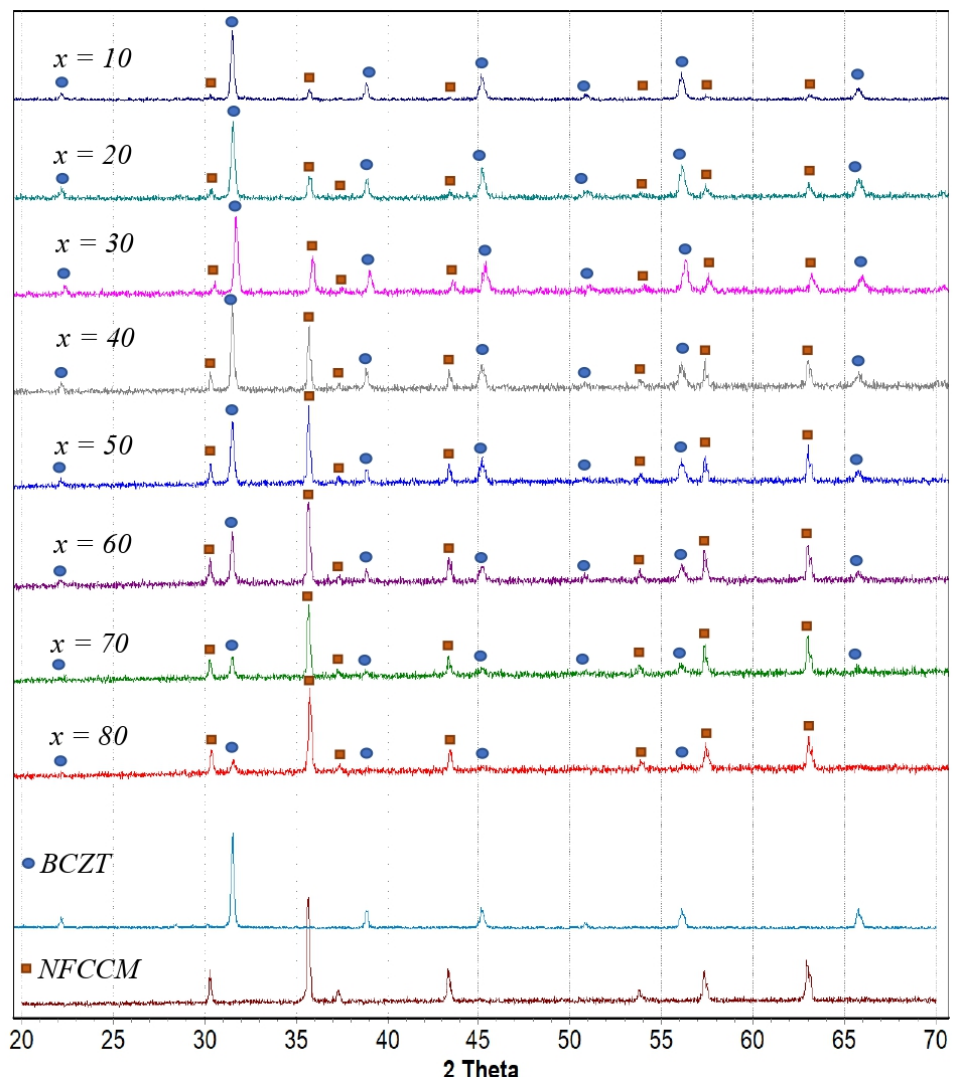
Figure 1. Powder XRD patterns of (100 − x) wt.% BCZT + x wt.% NCCMF composites and pure Figure 1. PowderXRDpatternsof(100 − x)wt.%BCZT+xwt.%NCCMFcompositesandpurecomponents. components. SEM images of (100 − x) wt.% BCZT + x wt.% NCCMF composite ceramics SEM images of (100 − x) wt.% BCZT + x wt.% NCCMF composite ceramics are pre-